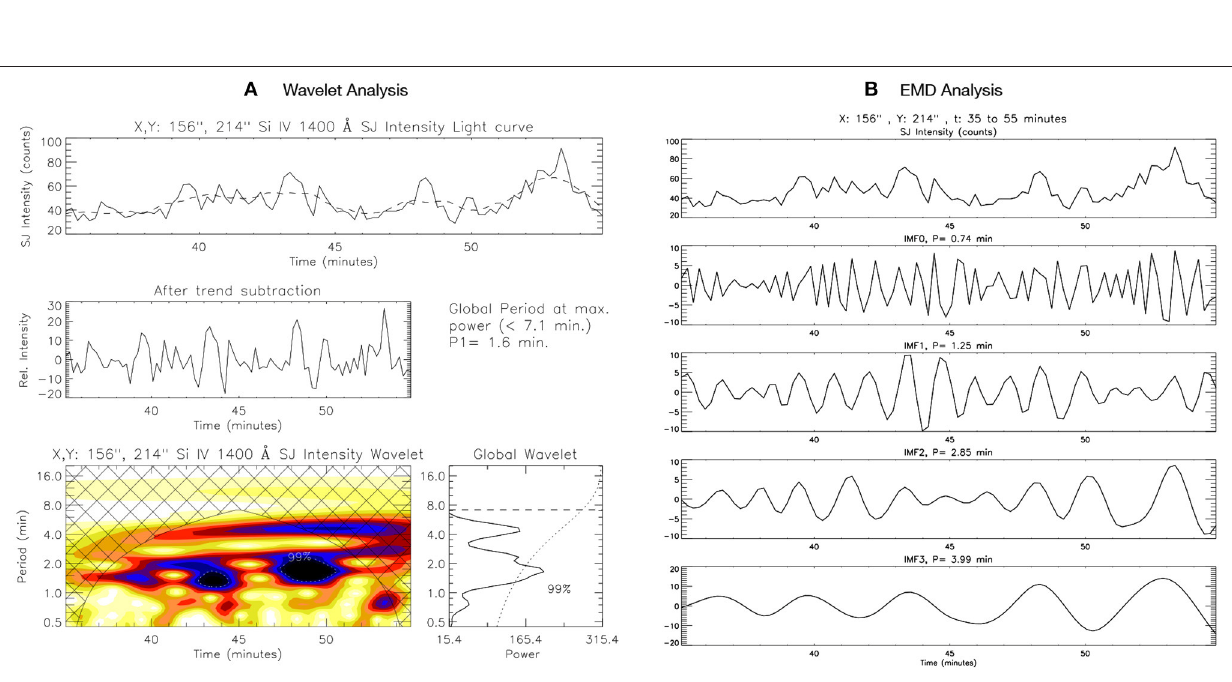
Frontiers in Astronomy and Space Sciences | www.frontiersin.org